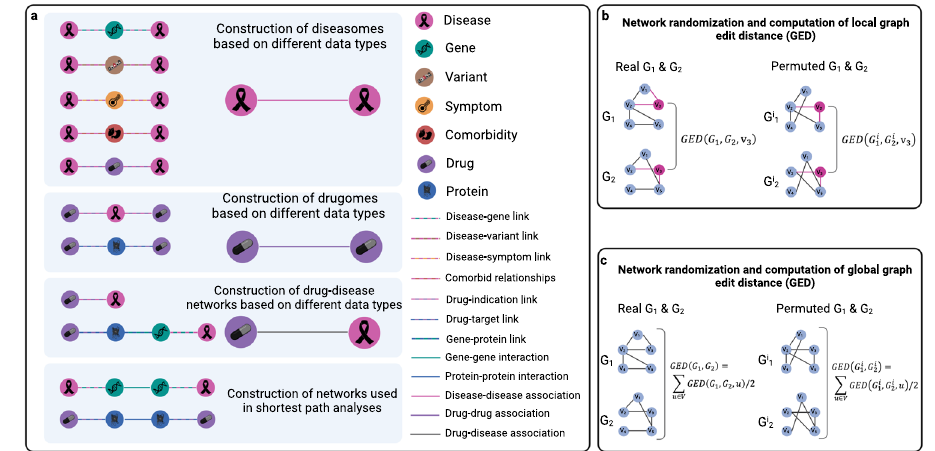
Fig. 3 | Overviewofcomparednetworks and graph editdistance computation. a We compared fi ve different types of disease-disease networks (diseasomes), two differenttypesofdrug-drugnetworks(drugomes),andtwodifferenttypesofdrug- disease networks. Pairwise comparisons between those networks were carried out using local and globalgraph editdistance(GED). b LocalGEDwasusedto quantify